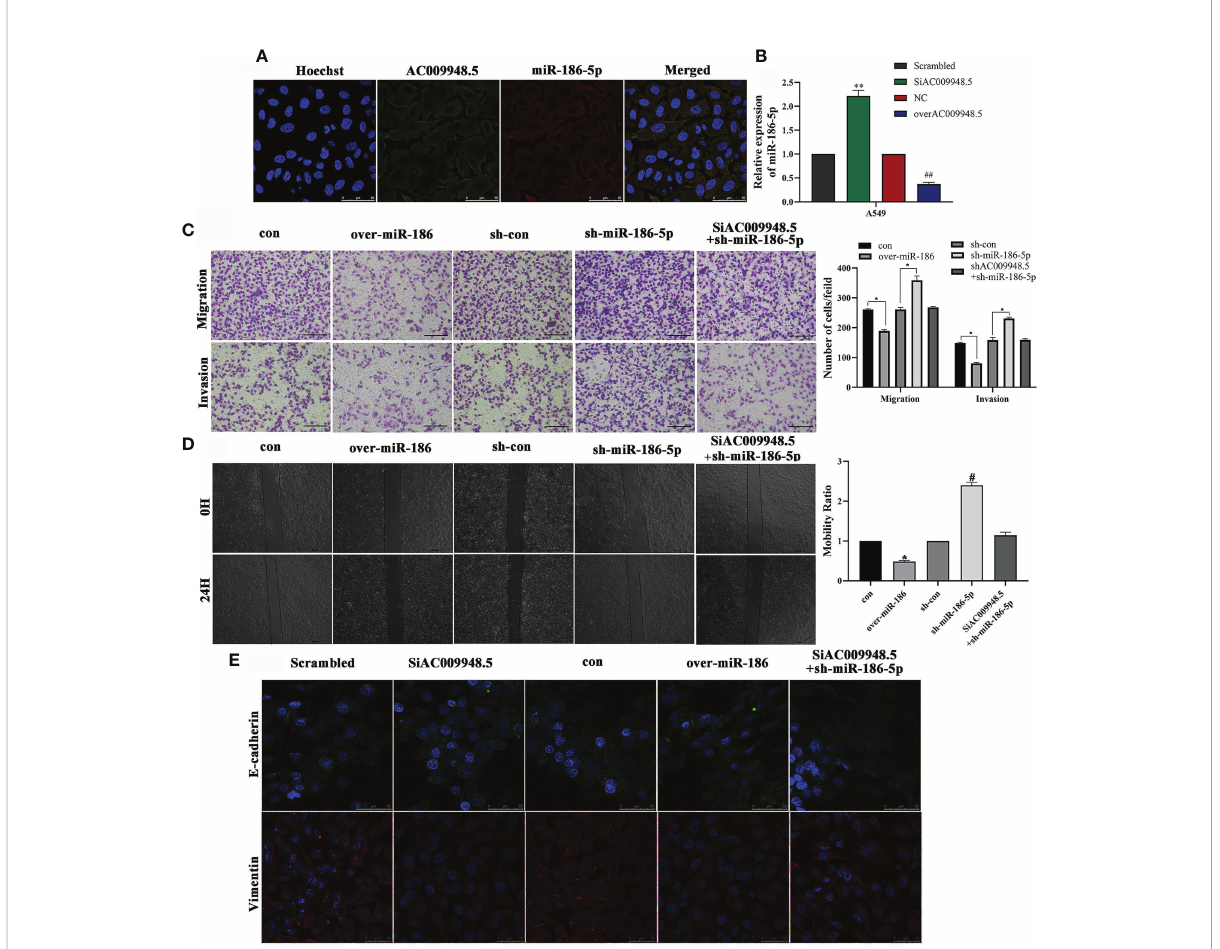
FIGURE 4 LncRNA-AC009948.5 affects the invasion, metastasis, and EMT of lung adenocarcinoma cells by targeting miR-186-5p. (A) RNA FISH showed that LncRNA-AC009948.5 was co-localized with miR-186-5p in A549cells. LncRNA-AC009948.5 probes were labeled with Cy-3, and miR-186- 5p were labeled with Fam. The nuclei were stained with DAPI. Scale bar = 50 µm. (B) miR-186-5p expression in SiAC009948.5 and overAC009948.5 stably transfected lung adenocarcinoma cells detected by qPCR. All experiments were repeated independently three times. Data are presented as means ± standard deviation. **P<0.01 compared with Scrambled/A549 cells (5B); ## P< 0.01 compared with NC/A549 group. (C) The invasion ability of the cells after co-infection was detected by Transwell assay. Data are represented by mean ± S.D. * P<0.05 compared with con (5C), sh/con (5C) group, determined by Student ’ s t-test. Invasive cells were counted and analyzed. (D) The mobility ability of infected cells was detected by wound healing assay. Data are represented by mean ± S.D. *P<0.05 compared with con, # P<0.05 compared with sh-con with NC/A549 group (5D). Scale bar, 500 µm. (E) Localization of EMT markers (E-cadherin (green) and Vimentin (red)) in A549 cells after co-infection by immuno fl uorescence analysis. DAPI (blue) was used to stain nuclear DNA (scale bar: 50 m